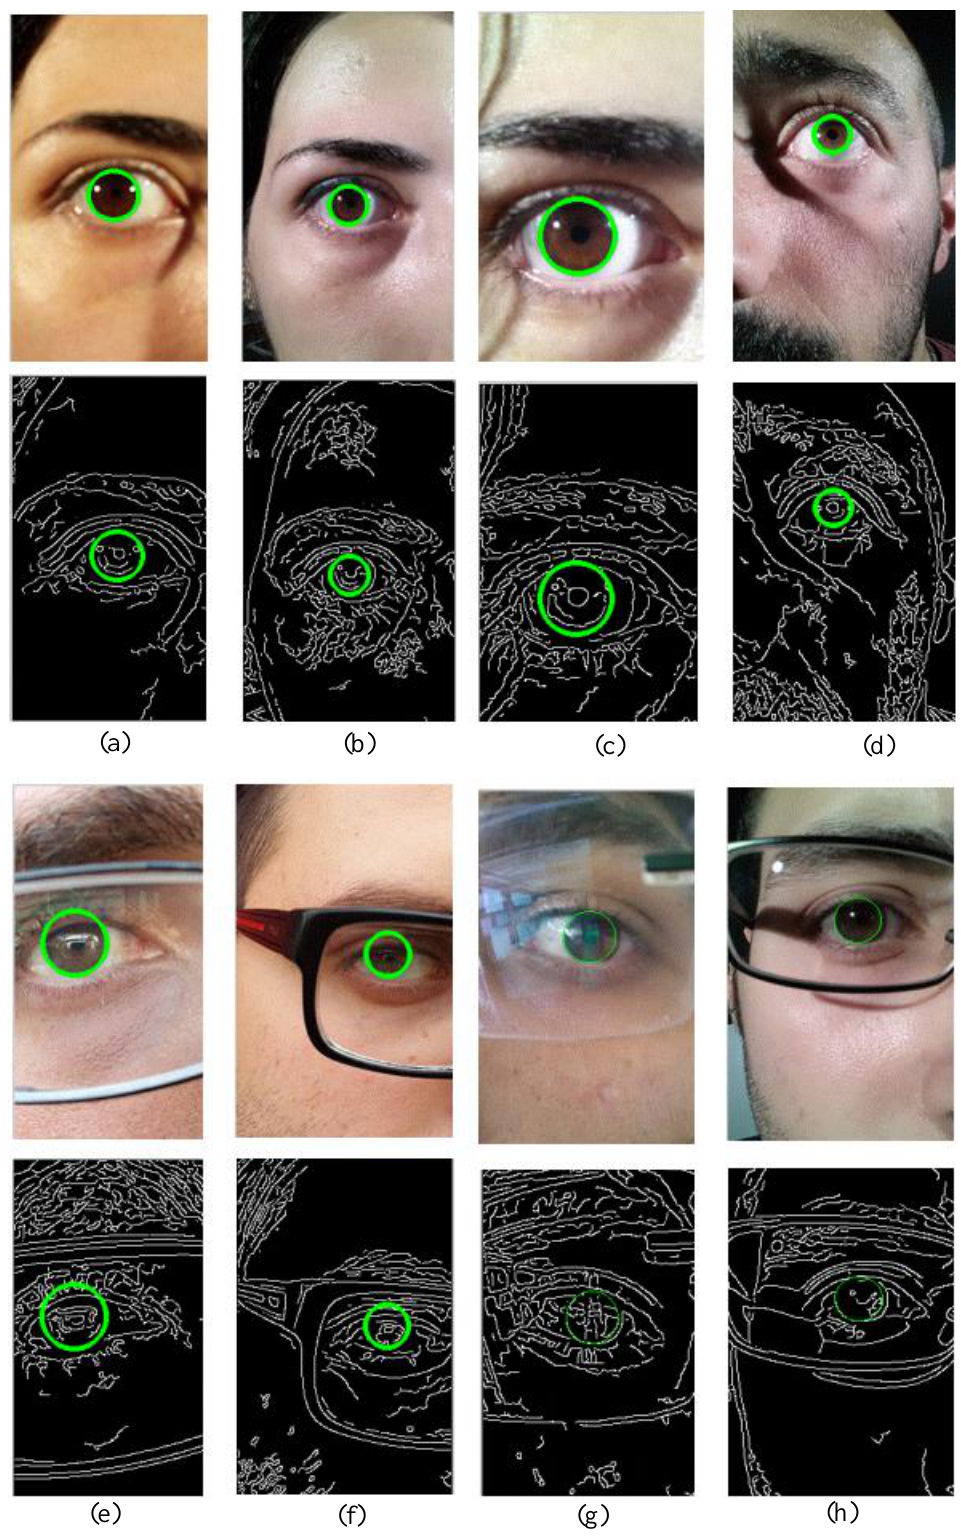
Figure 9. Results of iris detection on Galaxy Samsung S4